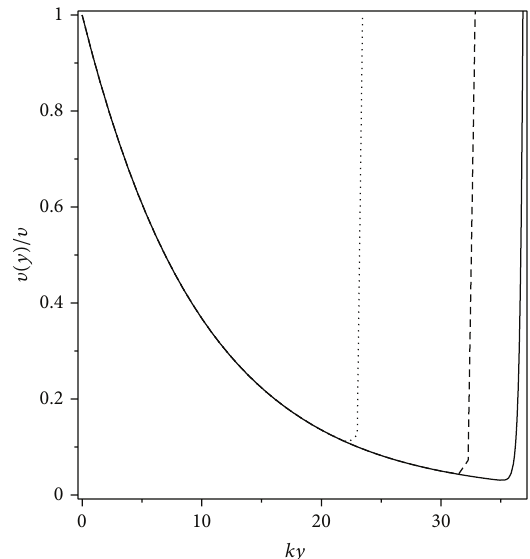
Figure 1: The VEV profile under (𝐷, 𝐷) BCs as a function of extra dimension for ℵ = 34 in the absence of brane potential with Ω < 0 and a positive tension visible brane. We take 𝜐 ≡ 𝜐 0,1,2,𝐿 ≡ 𝑀 3/2 𝑝𝑙 , ] = 2.1 , 𝑀 = 2.4 × 10 18 GeV. 𝑘 ≡ 𝑀 𝑝𝑙 , 𝑝𝑙